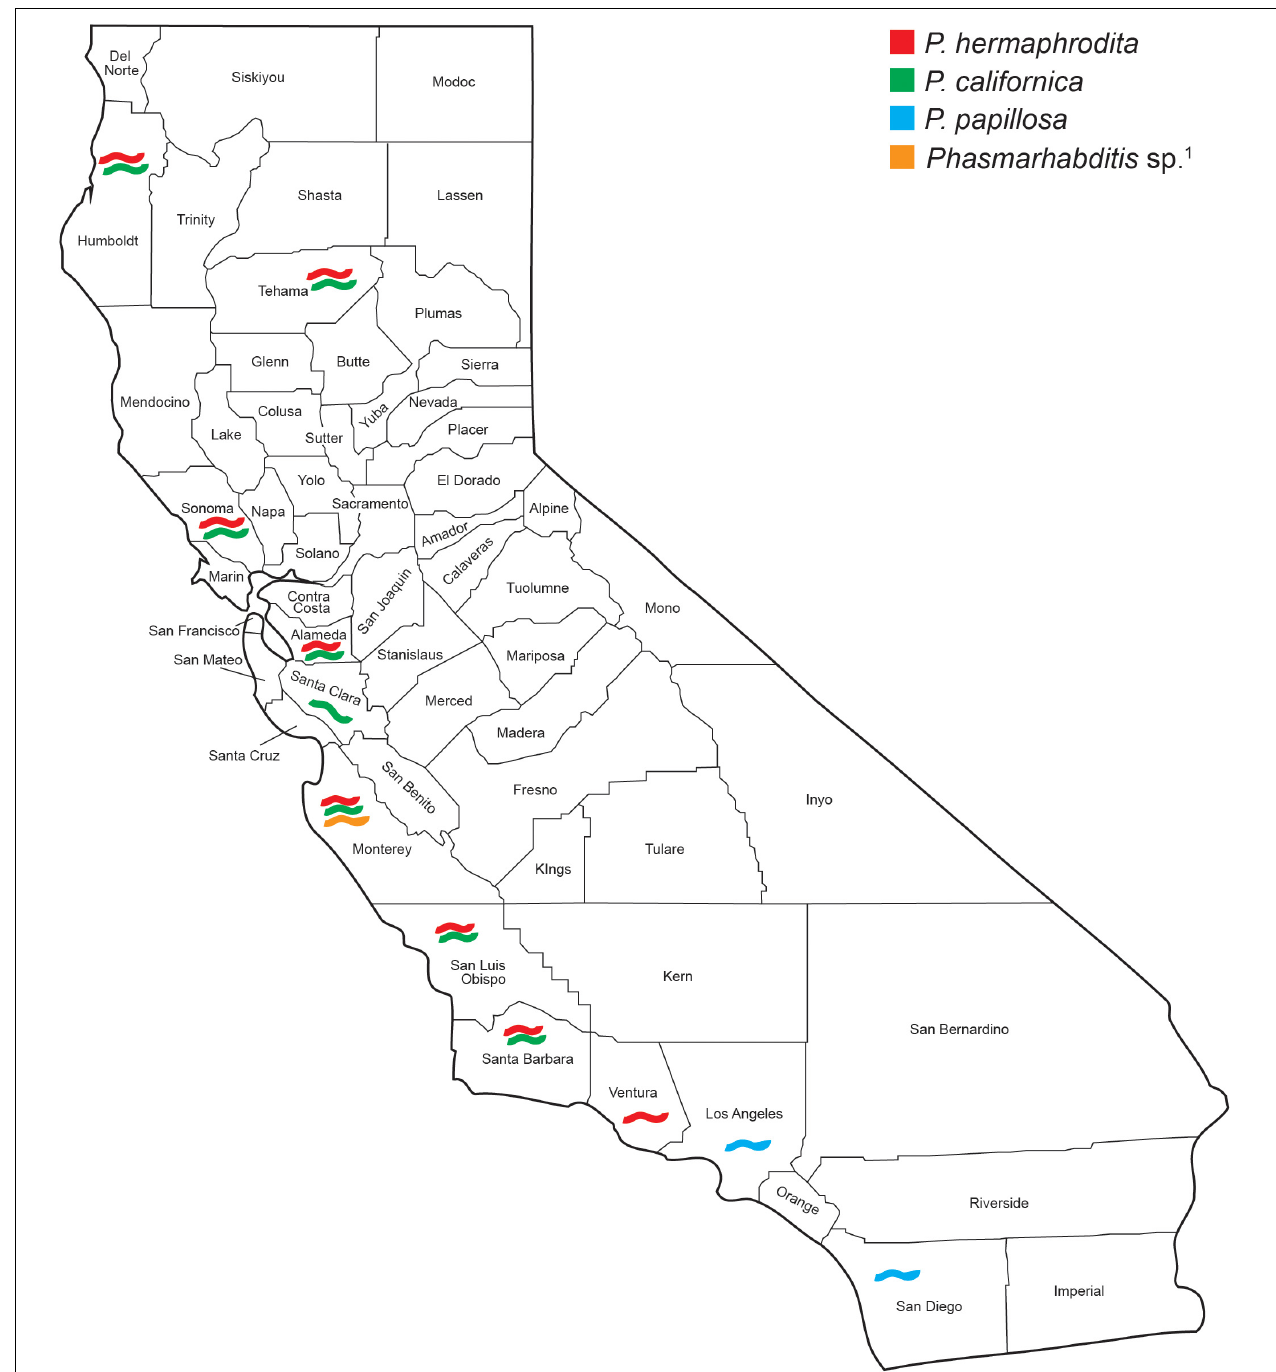
FIGURE 4 | Phasmarhabditis species recovery and distribution among 28 California counties surveyed between 2012 and 2021. Species were identified by sequencing the D2–D3 expansion segments of the large subunit (LSU or 28S) ribosomal RNA and contigs compared by BLAST with published sequences in GenBank. 1 Isolate closely related to Phasmarhabditis papillosa